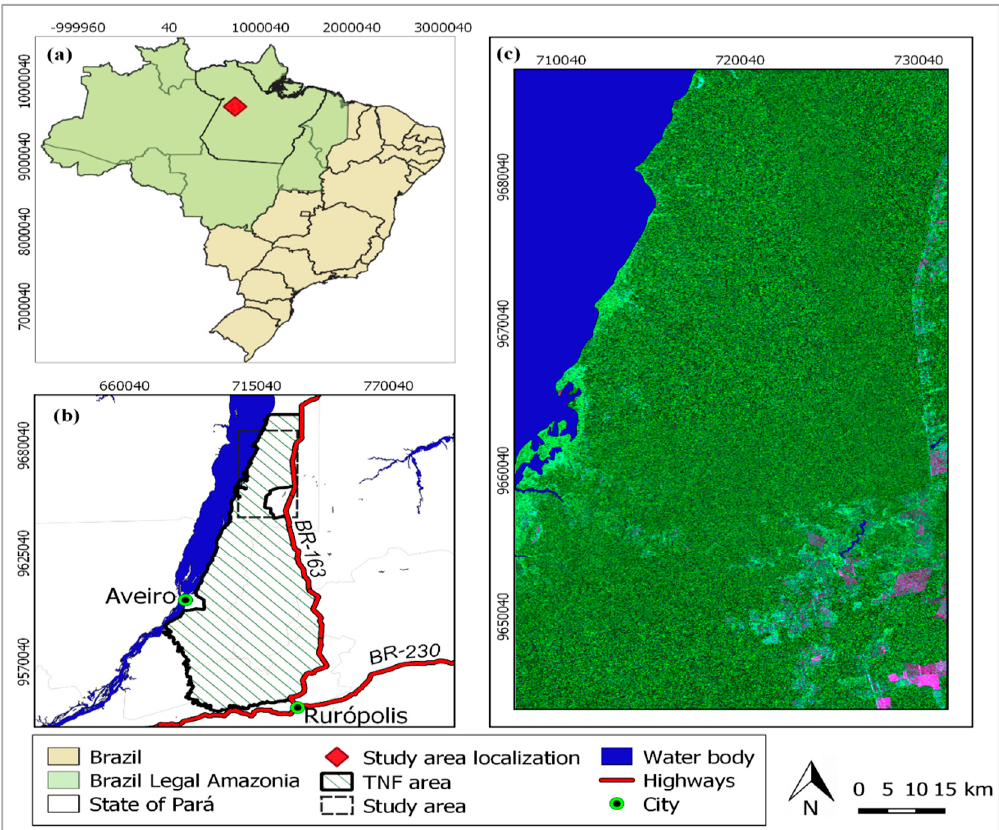
Figure 1. Location of the study area in the Pará State ( a ) and in the Tapajós National Forest ( b ). The image corresponds to the RGB color composite of HH/HV, VV/VH, and HH/VV ratios of ALOS/PALSAR-2 images mosaic ( c ) (overpasses in 28 December 2014, 19 April 2015, and 3 May